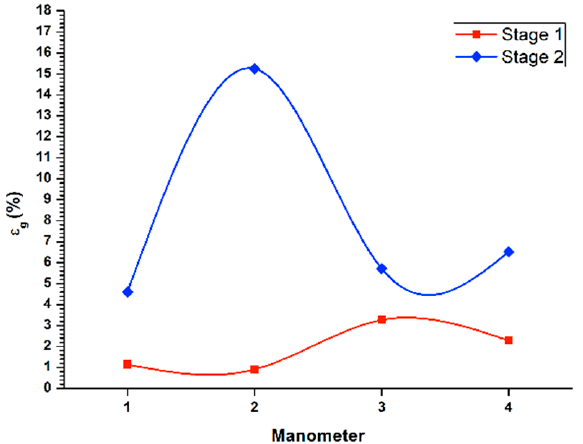
Figure 5. Determination of ε g , in the bath flotation column of the material of the “Dos Carlos” dam, for J IT of 0.68, 50 ppm of C 12 H 25 NH 2 as collector and 60 ppm of MIBC as foaming agent.